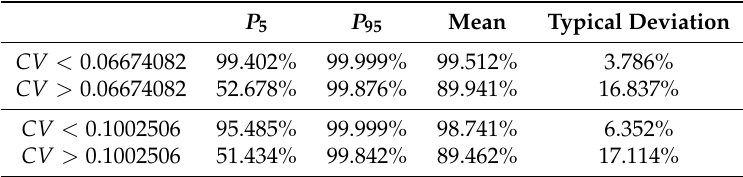
Table 6. Values of condition C1 depending on the coefficient of variation (CV).